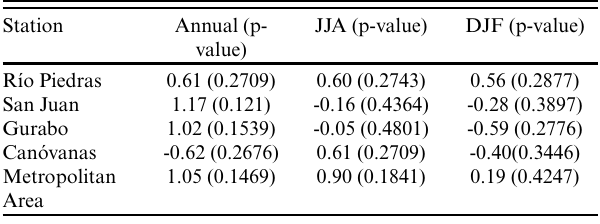
Table 7 . Mann-Kendall trend analysis for heavy